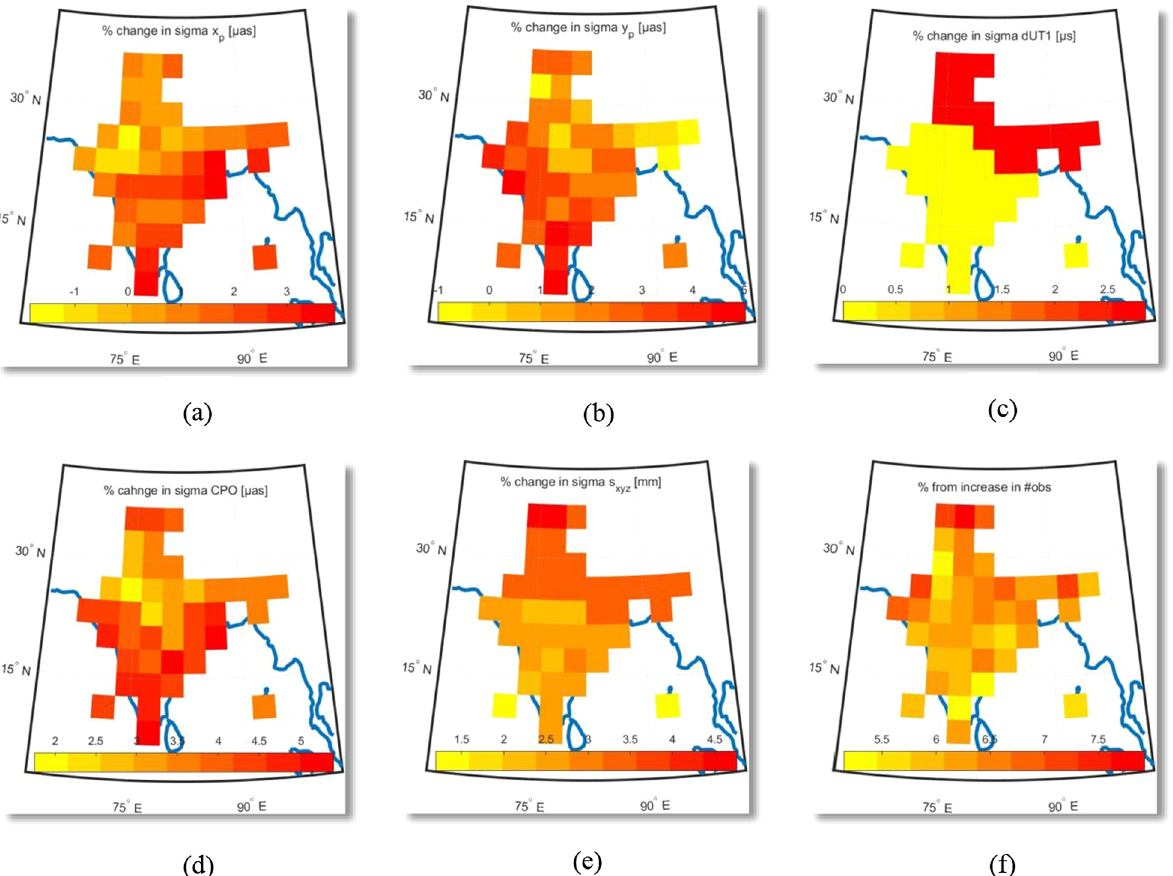
Fig. 8 a – e Percentage improvement in the mean formal error (sigma) of geodetic parameters in the fourth scenario; f expected improvement percentage from the increase in observations